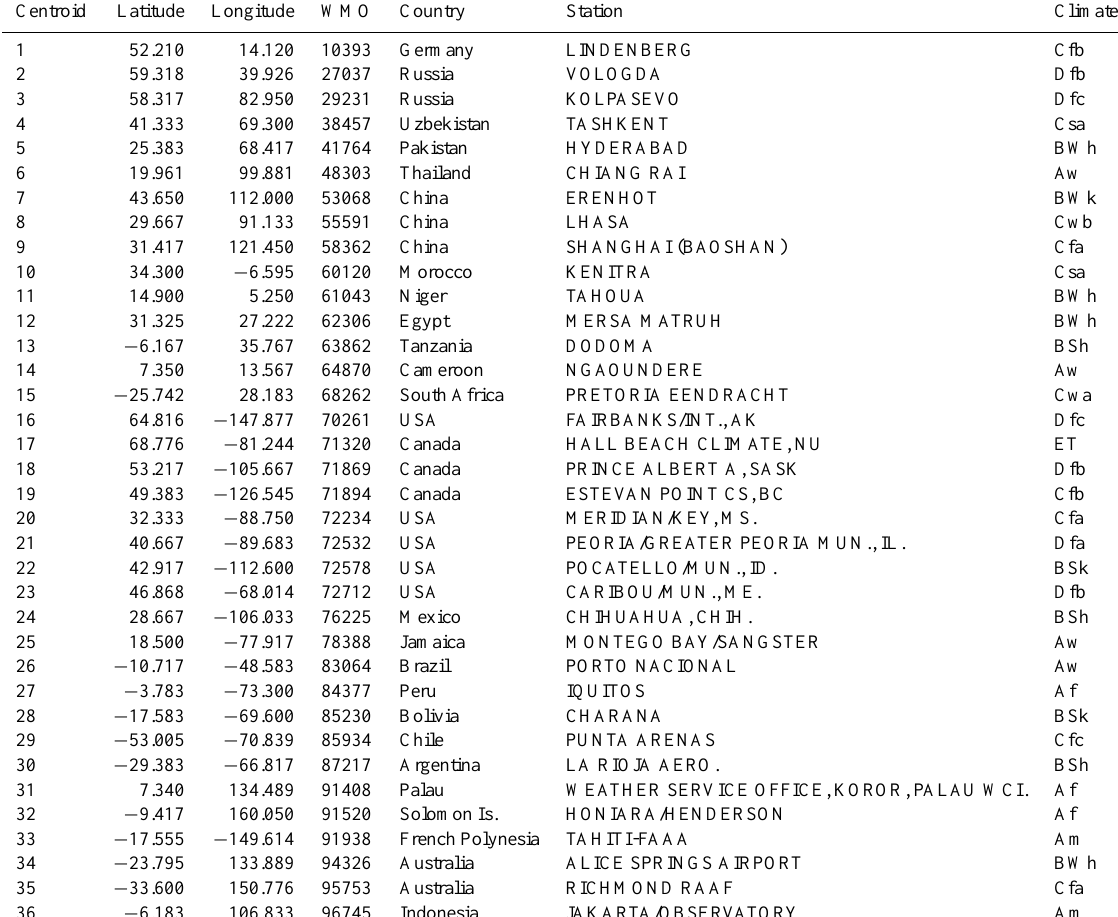
Table 2. The ID number, geographic centroid location, climatic zone, and WMO station of the climatic clusters used in RCWIP. Centroid Latitude Longitude WMO Country Station Climate 1